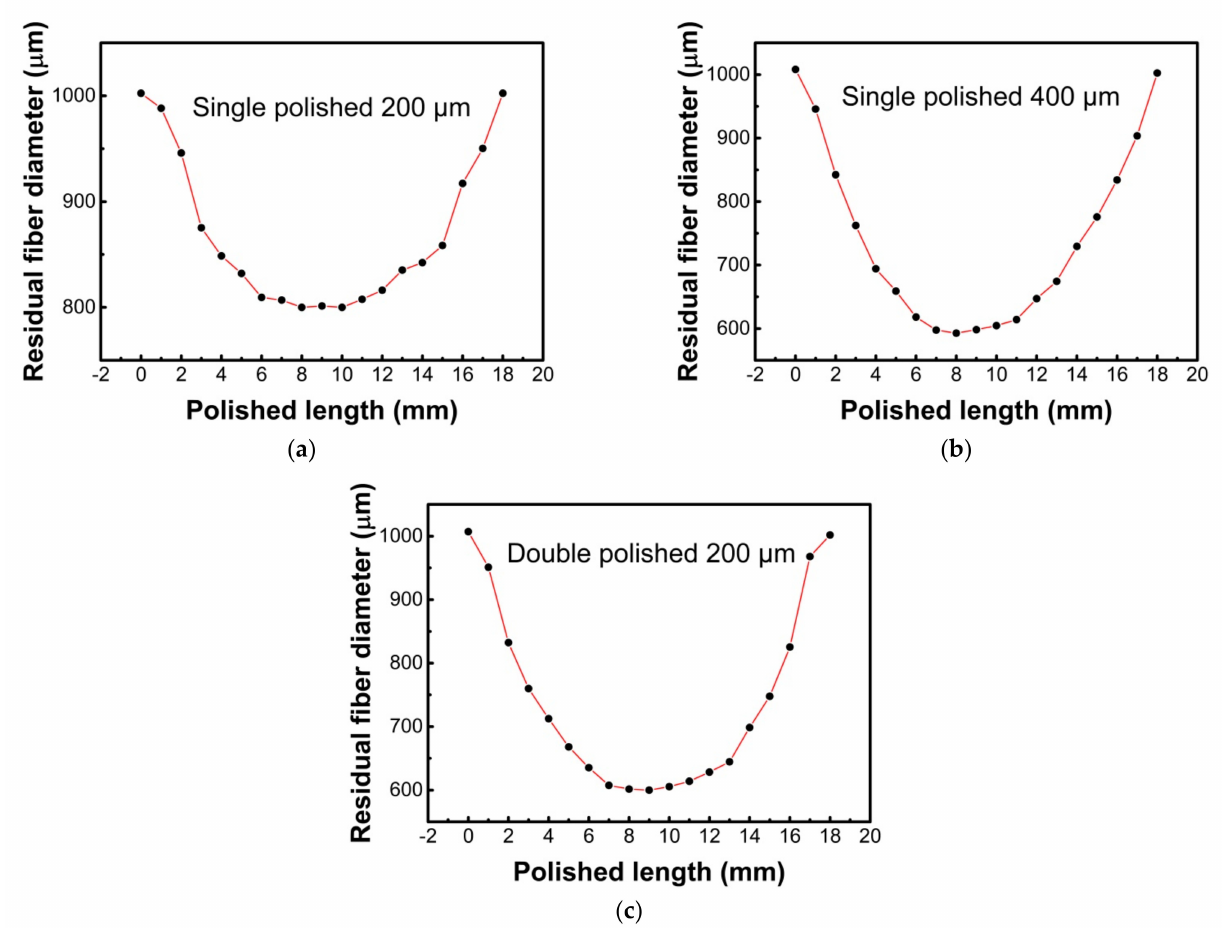
Figure 5. The structural parameters for the single and double-sided polished plastic optical fiber (POF) probes. For the single-sided polished SPR probe with polished depths of 200 µ m ( a ) and 400 µ m ( b ), and the double-sided polished SPR probe with a polished depth of 200 µ m ( c